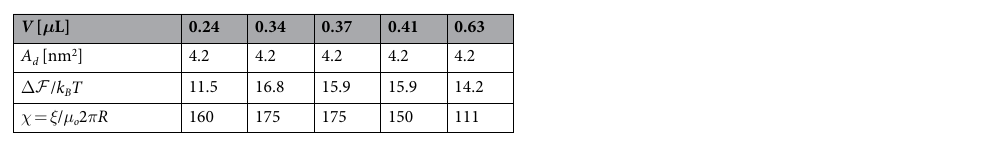
Table 1. Model parameters for analytical